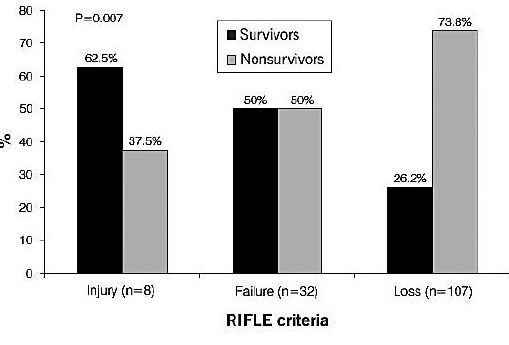
Figure 1 Mortality associated with RIFle criteria for acute kidney injury in patients admitted to an infectious diseases inten- sive care unit in Brazil. Scores in patients with acute kidney injury admitted to an infectious diseases ICU.